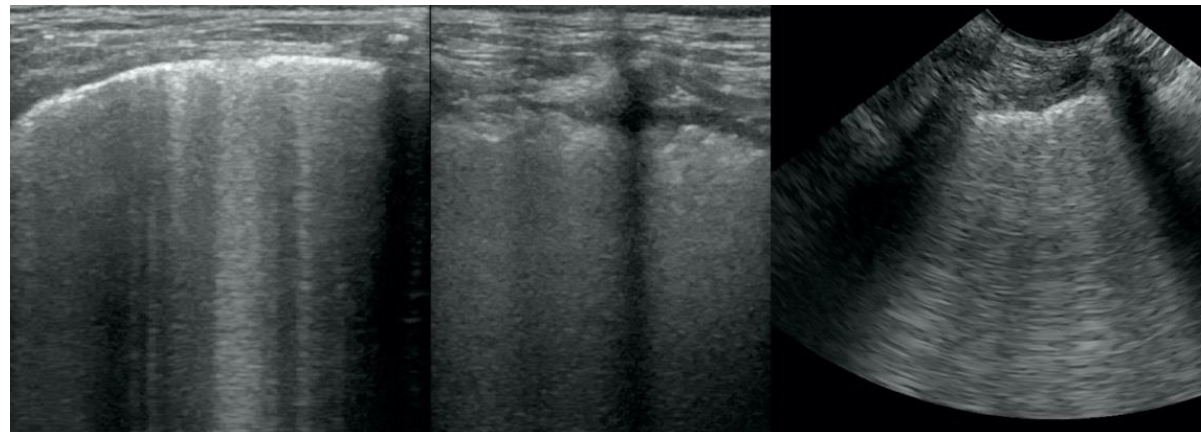
Figure 1. Irregular and thickened pleural line.